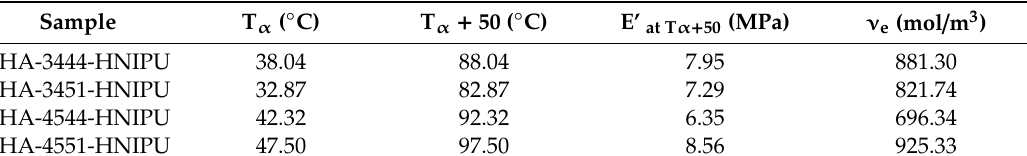
Table 4. HNIPU parameters obtained from the DMA.